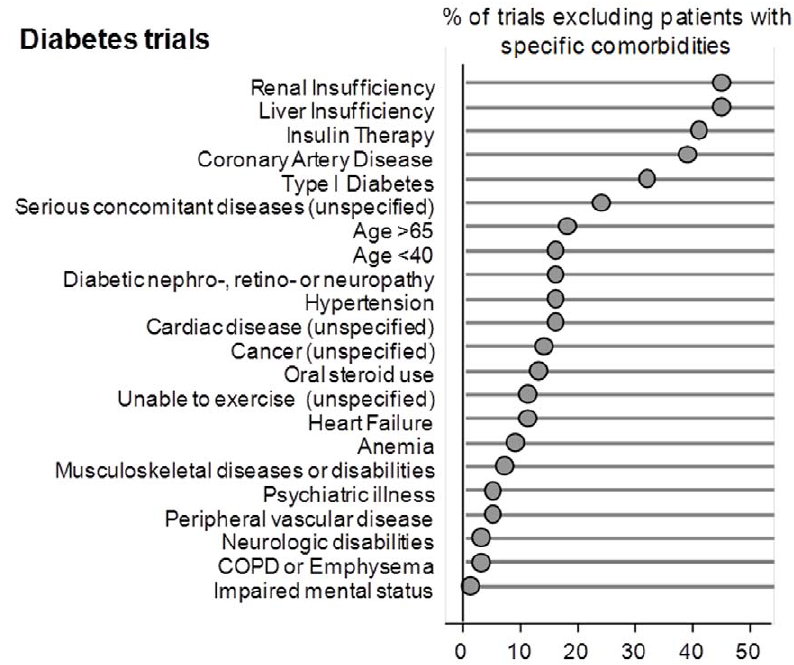
Figure 3. Proportion of diabetes trials where patients with specific comorbidities were excluded.